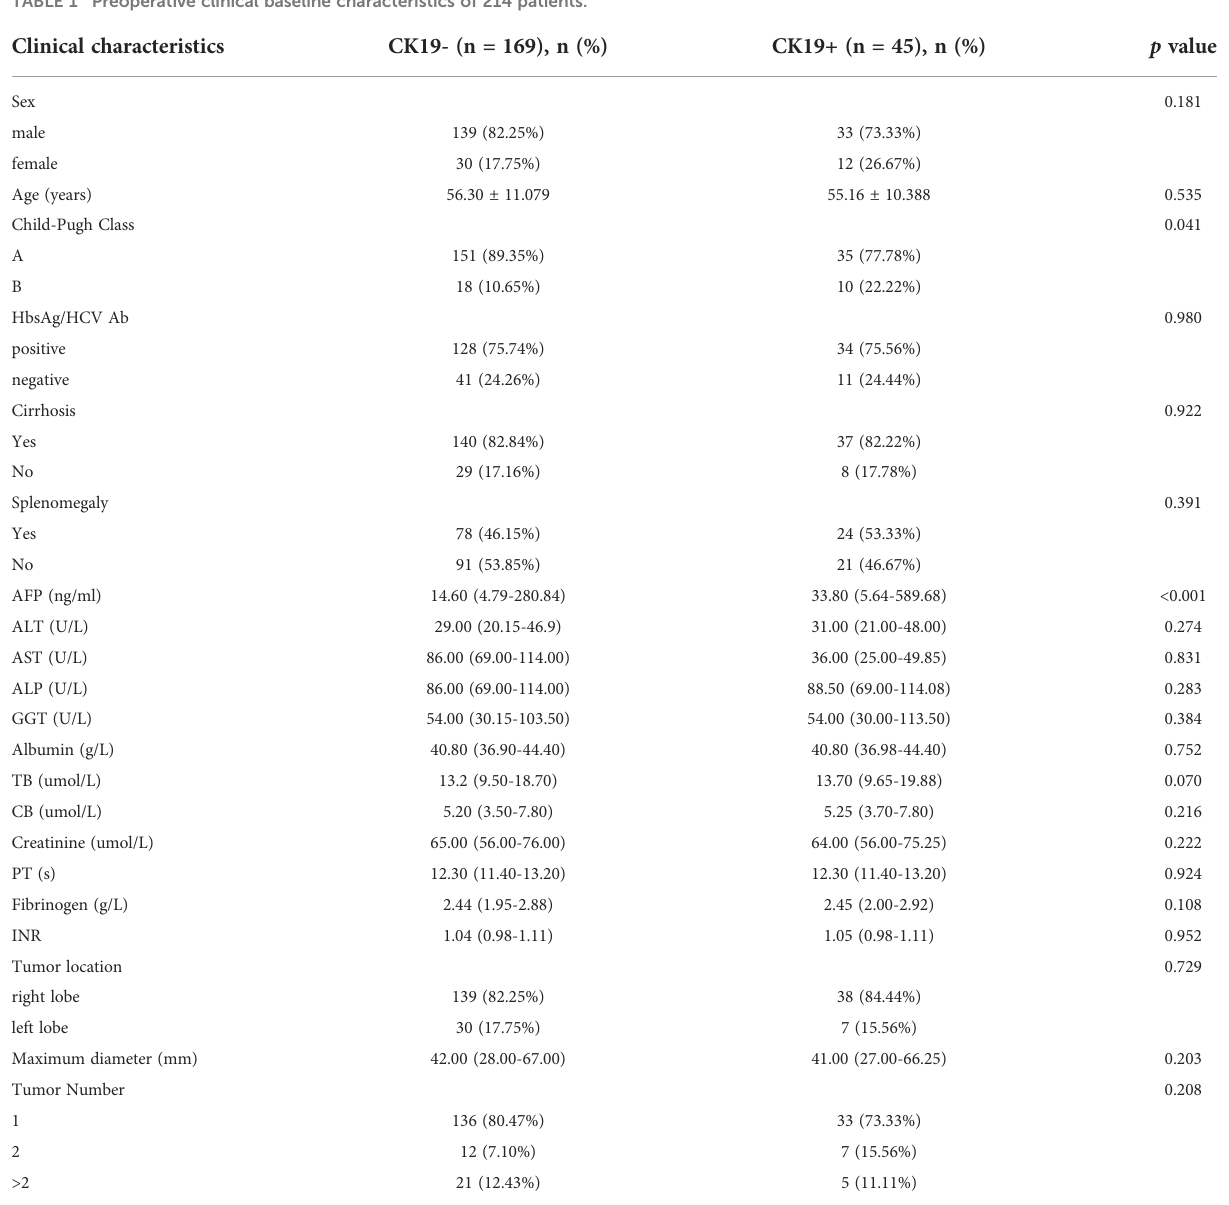
TABLE 1 Preoperative clinical baseline characteristics of 214